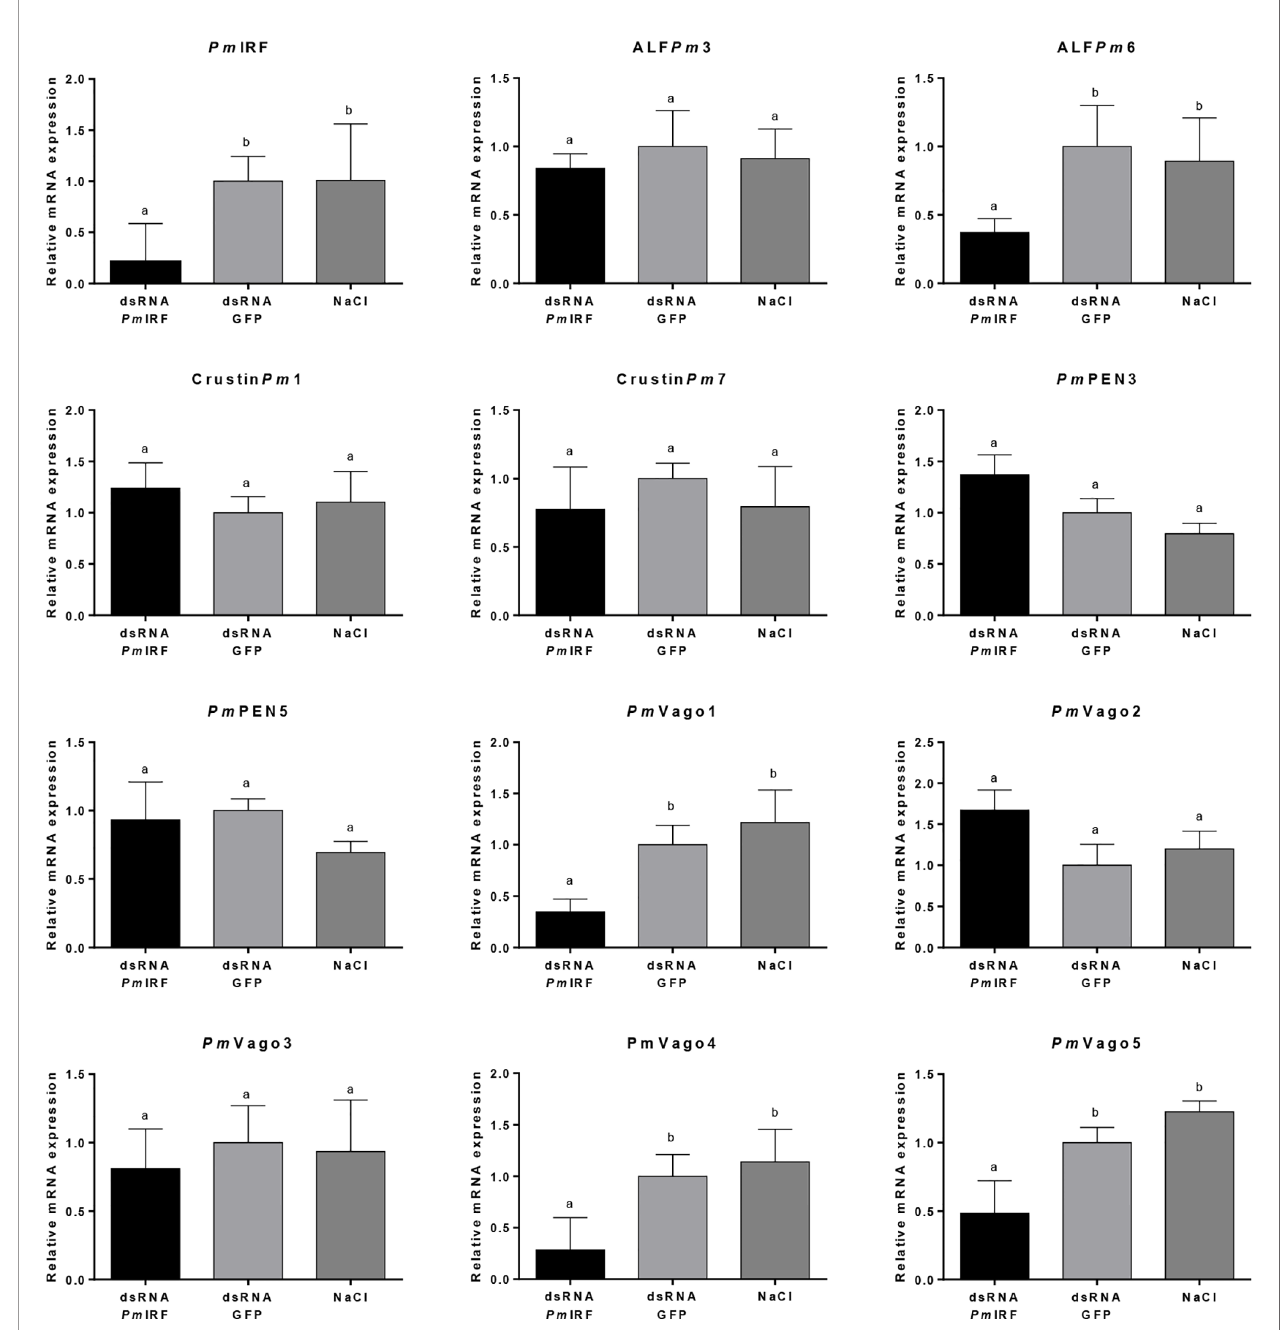
FIGURE 1 | Effect of PmIRF knockdown on the expression levels of antiviral and antimicrobial peptide genes. Shrimps were injected with Pm IRF dsRNA, GFP dsRNA, or 150 mM NaCl. After 24h, the intestine was collected for qRT-PCR analysis. EF 1 - a was used as an internal control. Data represent mean ± SD of 3 independently replicated experiments. Signi fi cant difference in the mean relative expressions compared with the control group at the level of P < 0.05 is indicated by a different lowercase